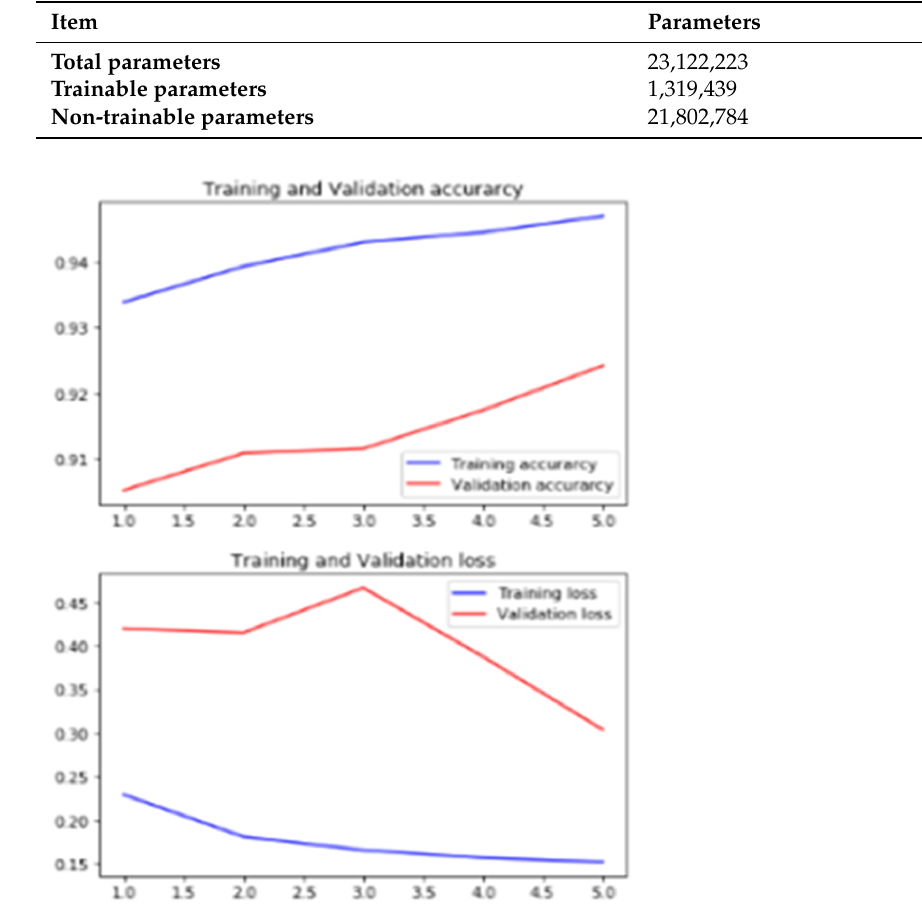
Figure 14. Classification Loss and Accuracy using INCEPTION V3 network